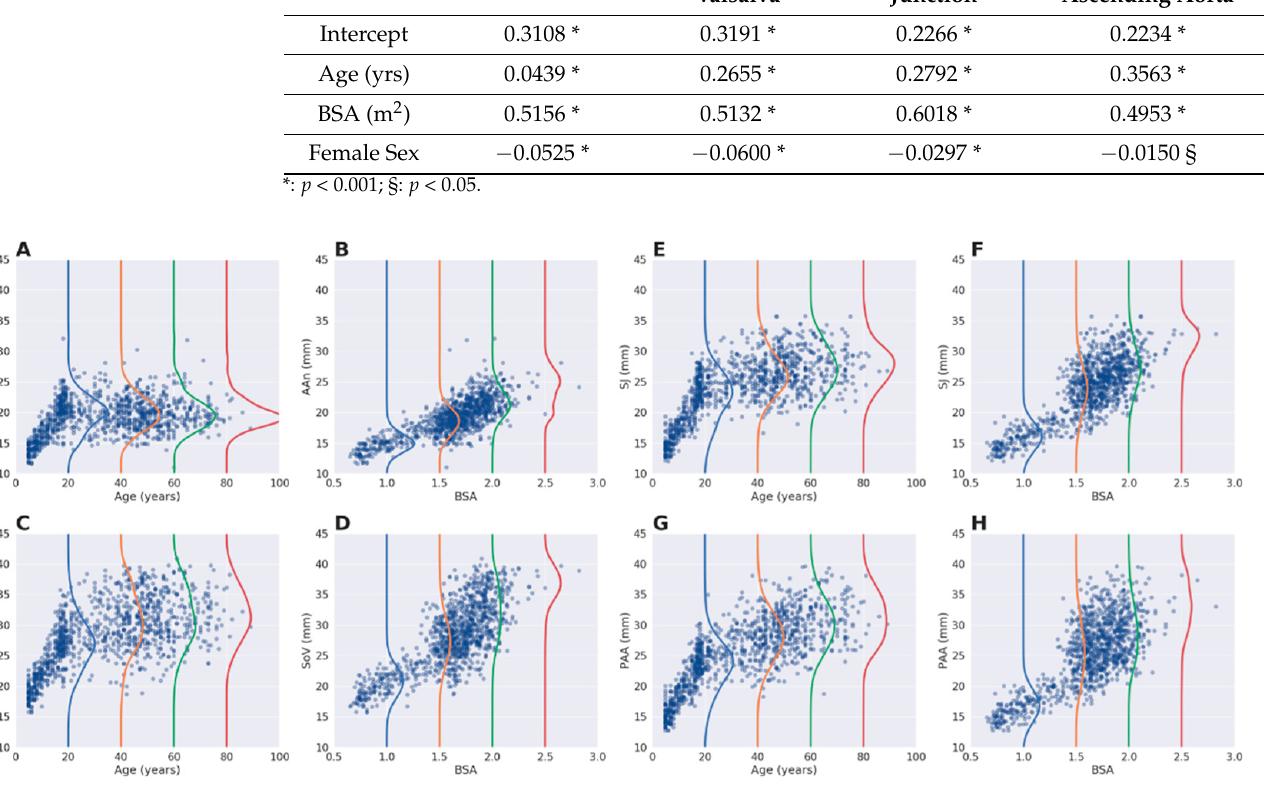
Figure 3. Scatterplots of individual patient aortic size related to age and body size. Individual patient data are reported to illustrate the relationship between either age or body surface area (BSA) and aortic size at the annulus (AAn; A , B ), sinuses of Valsalva (SoV; C , D ), sino-tubular junction (SJ; E , F ) and proximal ascending aorta (PAA; G , H ). Colored lines (or curves) represent the distribution of the variance of aortic size for the given values of age and BSA.